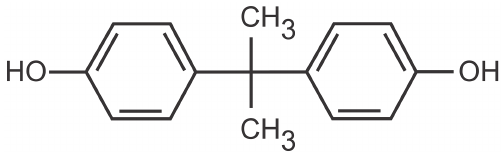
Figure 1. Structure of Bisphenol A.